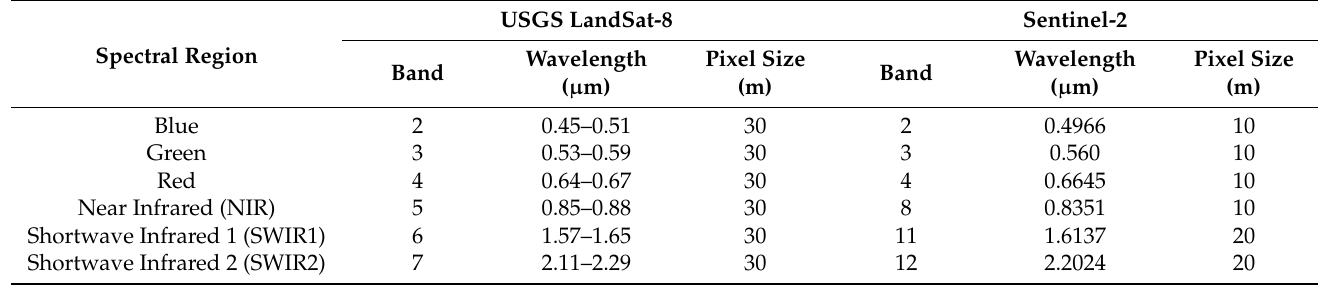
Table 1. Characteristics of USGS LandSat-8 and Sentinel-2 multispectral sensors.